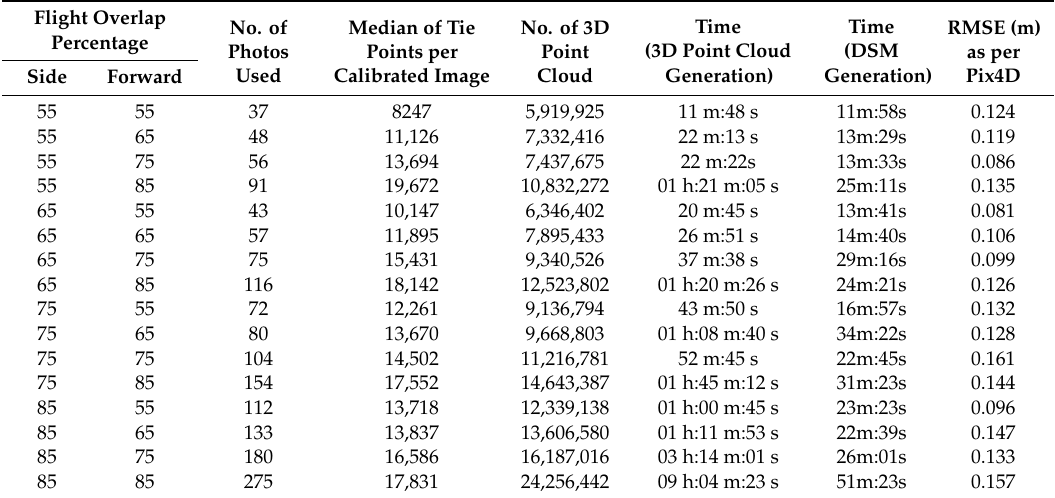
Table 2. Comparative statistics of Unmanned Aerial Vehicle (UAV) Photogrammetric products. Flight Overlap No. of Percentage Photos